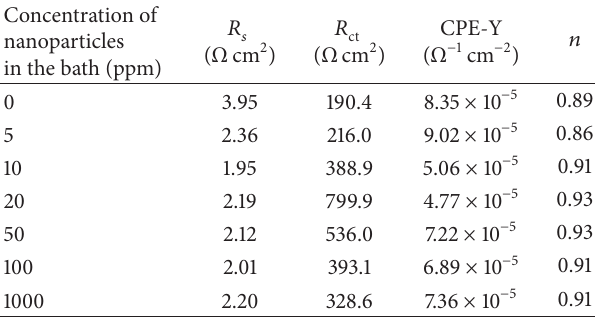
Table 2: Corrosion parameters of coatings in 0.5 M H from EIS